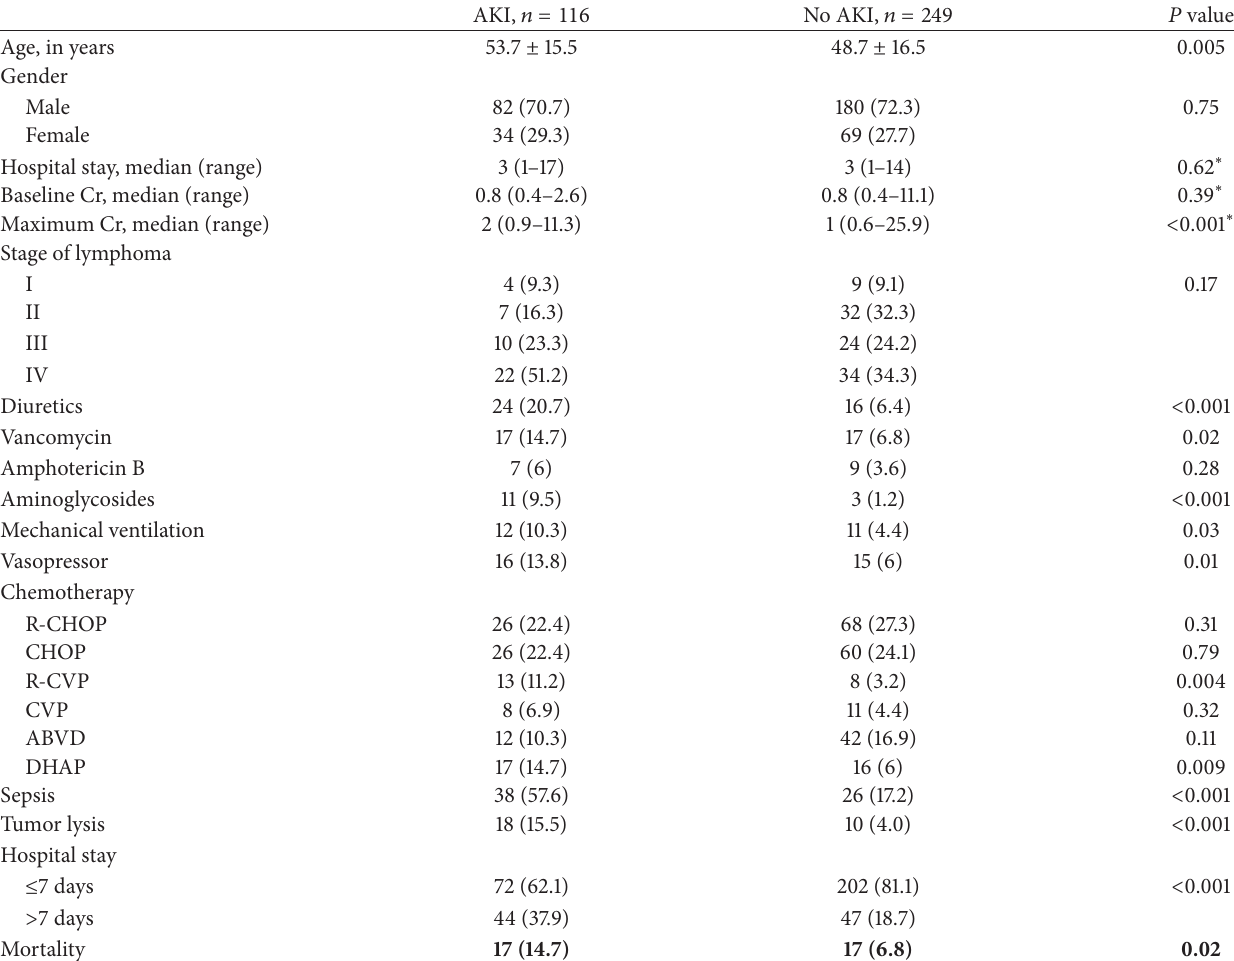
Table 2: Univariate analysis of factors associated with progression of AKI ( 𝑛 = 365 ).